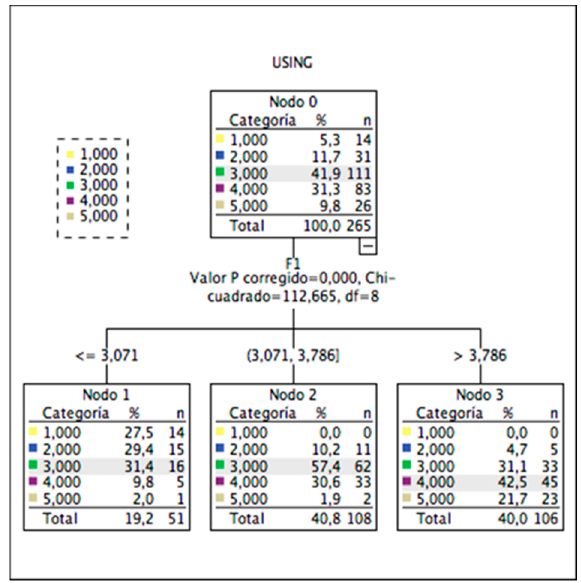
Figure 4. Decision tree by Chi-Squared Automatic Interaction Detector (CHAID).